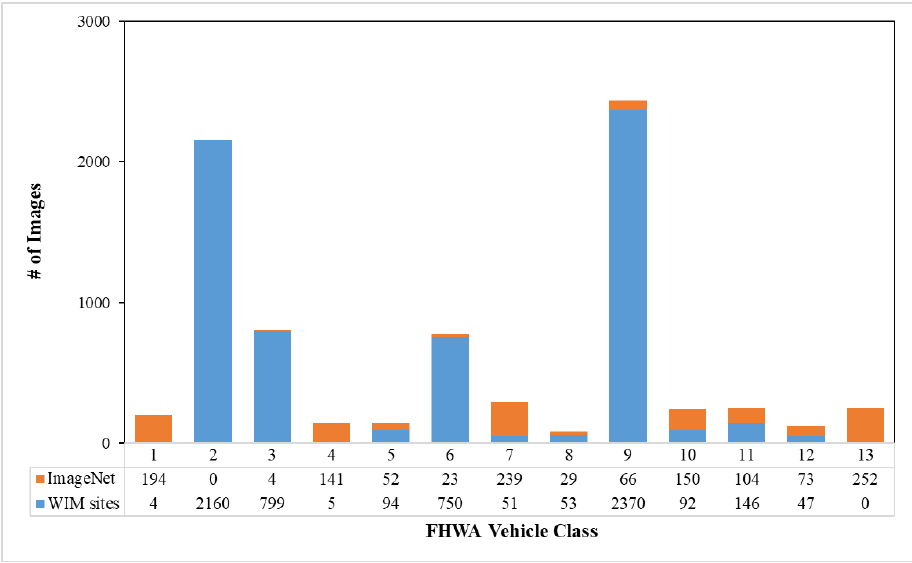
Figure 1. Distribution of image data among 13 FHWA classes from WIM sites and ImageNet. Given the varying scale of vehicles relative to the image frame, the vehicles were cropped from the original images to remove the irrelevant background information. All models were trained based on the cropped vehicle